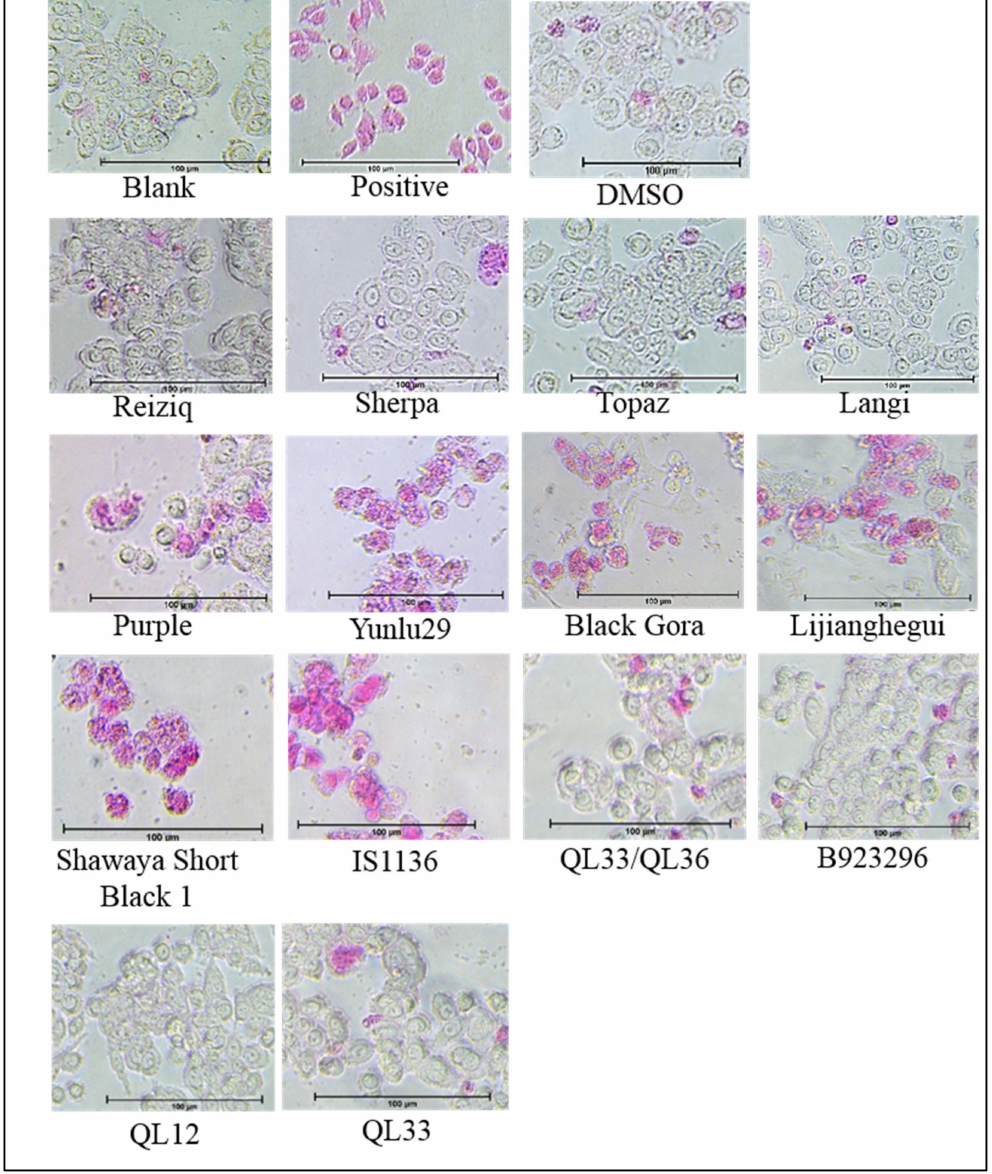
Figure 2. Apoptotic cells have compromised cell membrane which allows the APOPercentage dye (pink) to enter the cell. Retention of the dye after washing indicates apoptotic cell death in SW480 cells treated with rice and sorghum extracts at 24